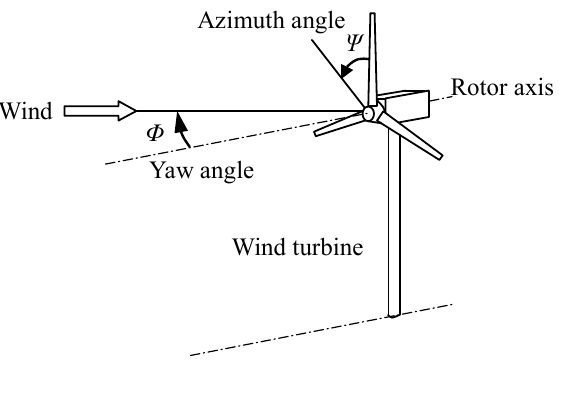
Figure 3. Azimuth and yaw angles